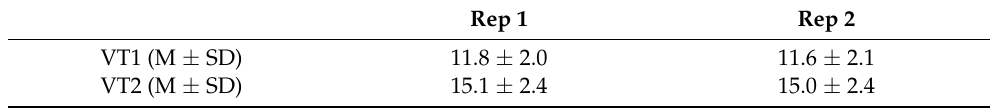
Table 2. Rate of perceived exertion (RPE) descriptive